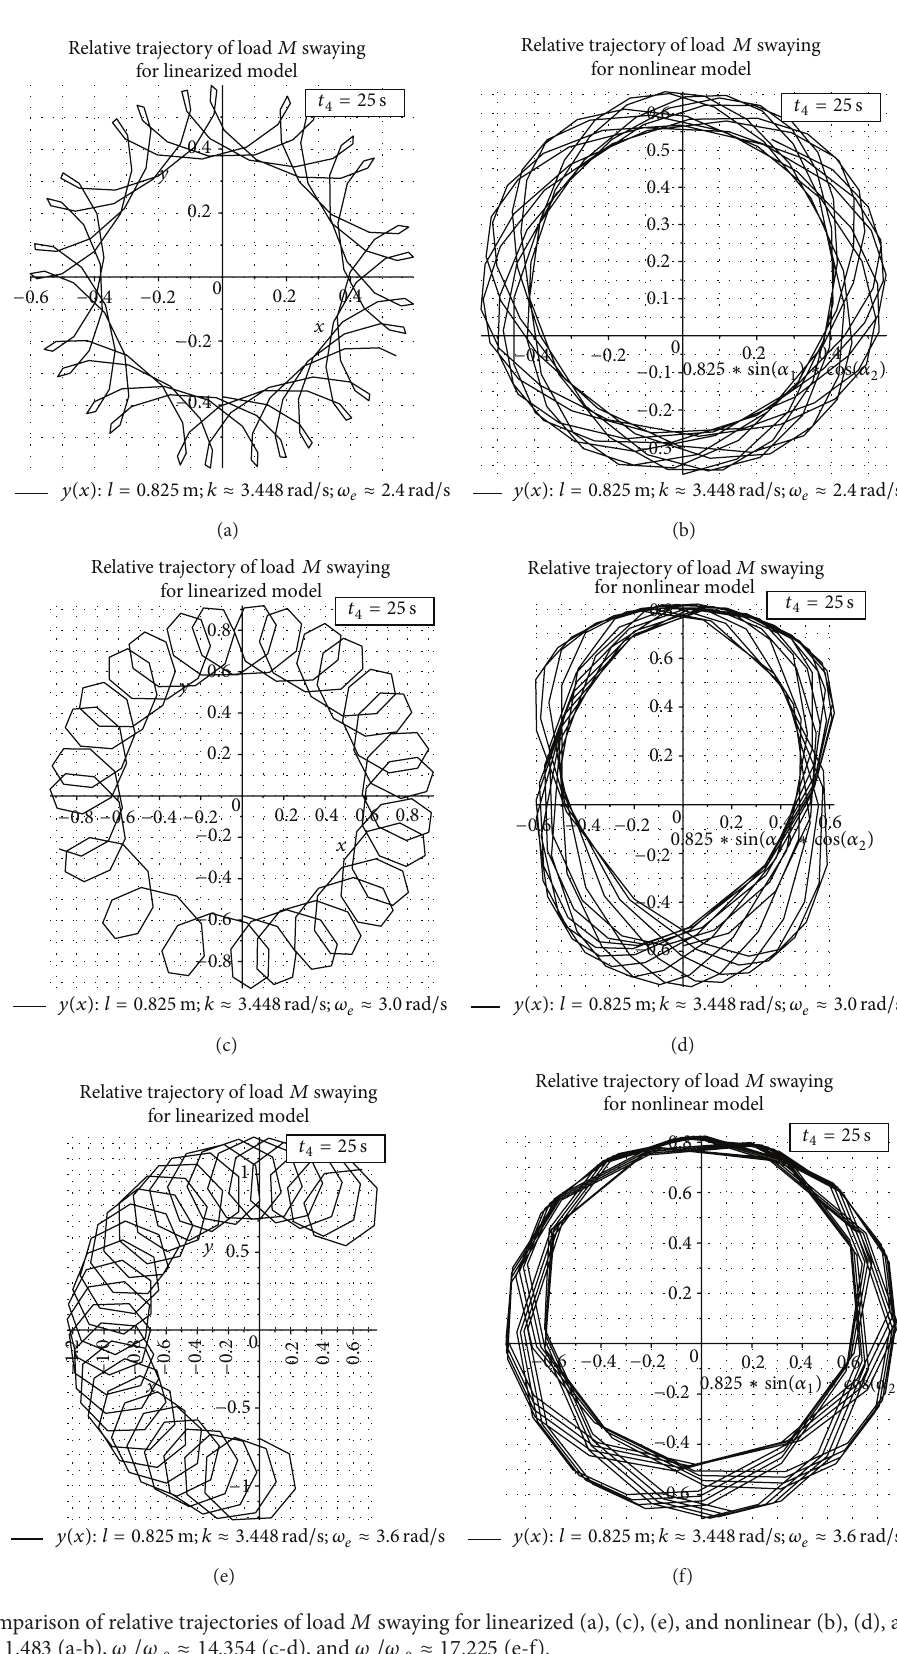
Figure 18: The comparison of relative trajectories of load 𝑀 swaying for linearized (a), (c), (e), and nonlinear (b), (d), and (f) models in the cases of 𝜔 𝑒 /𝜔 𝑒0 ≈ 11.483 (a-b), 𝜔 𝑒 /𝜔 𝑒0 ≈ 14.354 (c-d), and 𝜔 𝑒 /𝜔 𝑒0 ≈ 17.225